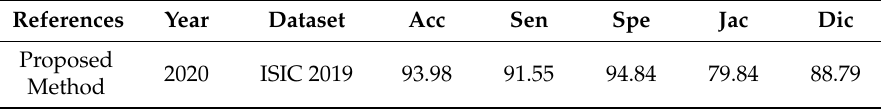
Table 11. The outcome of the proposed segmentation performance (%) on ISIC 2019